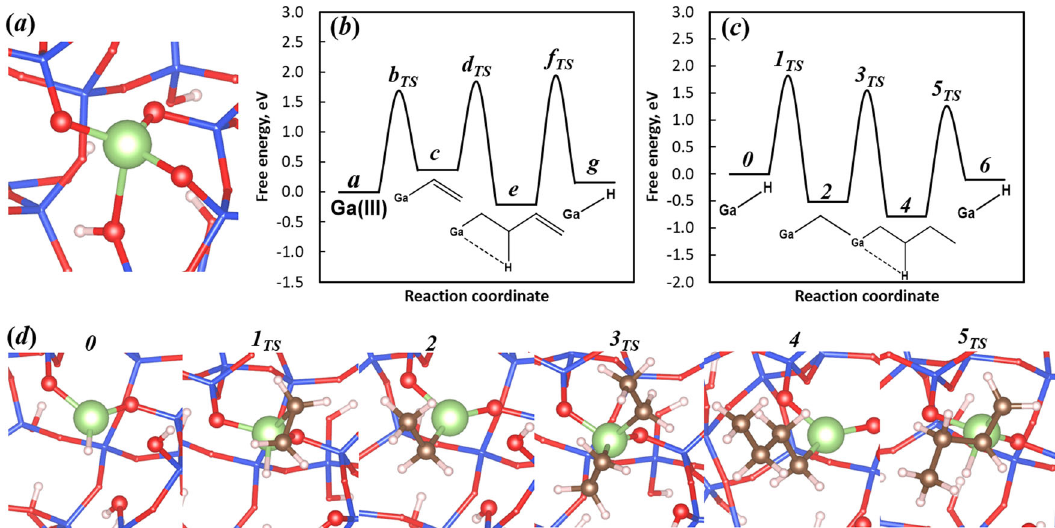
Fig. 4 Ga structures and energies during activation and oligomerization catalysis. a Ga site model where Ga = green, O = red, Si = blue, and H = white. b Free energy diagram of Ga – H formation on 4CN Ga site ( T = 250°C). c Free energy diagram of oligomerization on Ga – H ( T = 250 °C). d Schematic of ethylene oligomerization on Ga – H and the associated reaction intermediates and transition states.